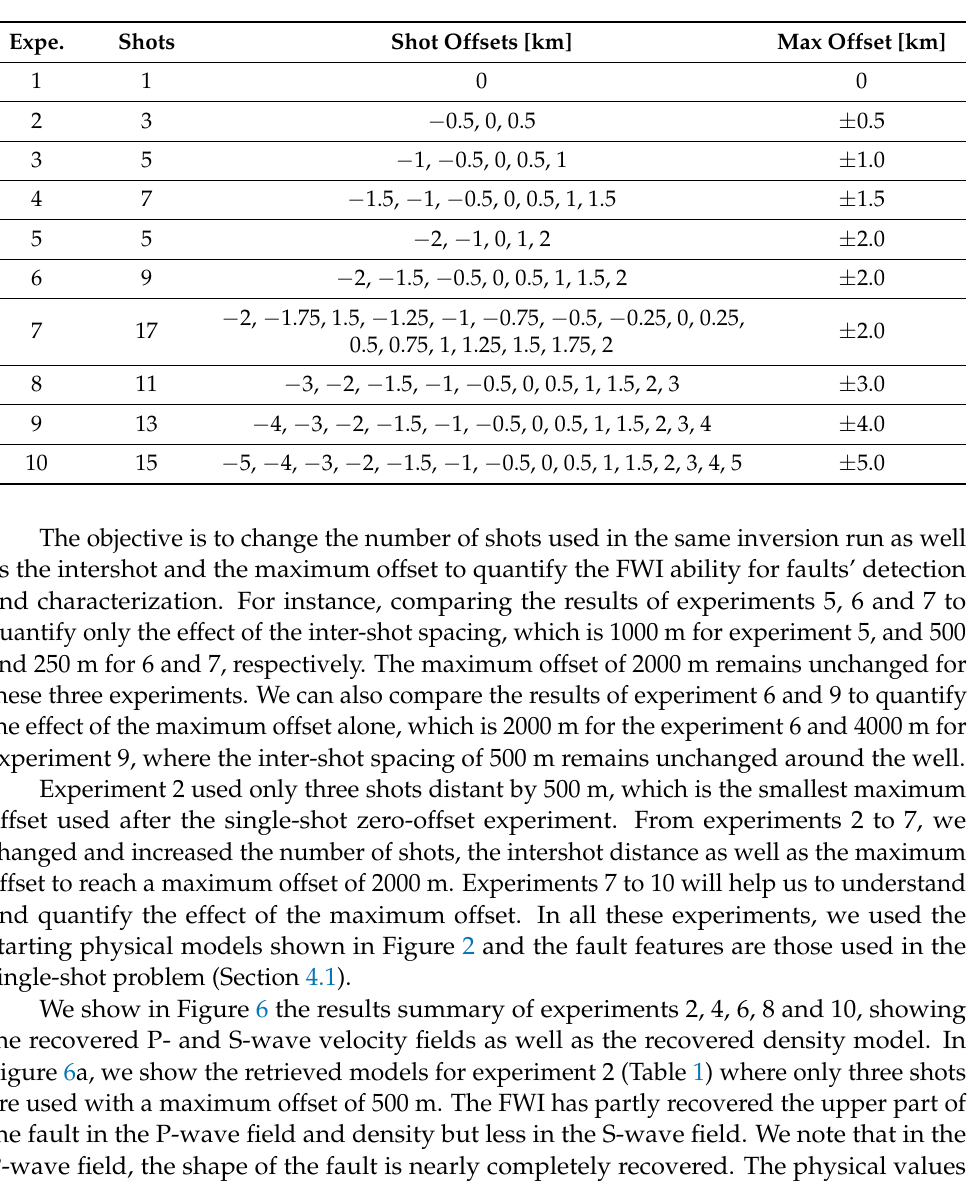
Table 1. Geometry data acquisition parameters used in the sensitivity study for fault detection, delineation and